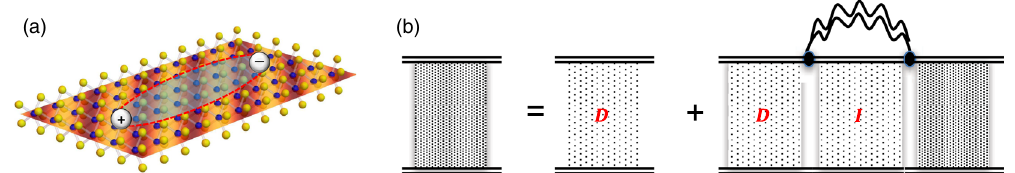
FIG. 7. Coupling between excitons and shortwave plasmons. (a) Cartoon of the exciton and shortwave charge fluctuations. The plasmon wavelength is shorter than the exciton extent, which is further blown up because of screening. (b) Feynman diagram representation of the renormalized direct-exciton pair function due to shortwave plasmons. The self-energy term takes into account the coupling between direct and indirect excitons ( D and I ) due to the electron-plasmon interaction. The hole (bottom propagator) acts as a spectator, while the electron interacts with the plasmon. The double wiggly lines in this diagram denote the plasmon propagator, and the vertices denote the electron- plasmon interaction. The diagram is an infinite sum of the virtual processes D þ DID þ DIDID þ (cid:2) (cid:2) (cid:2)